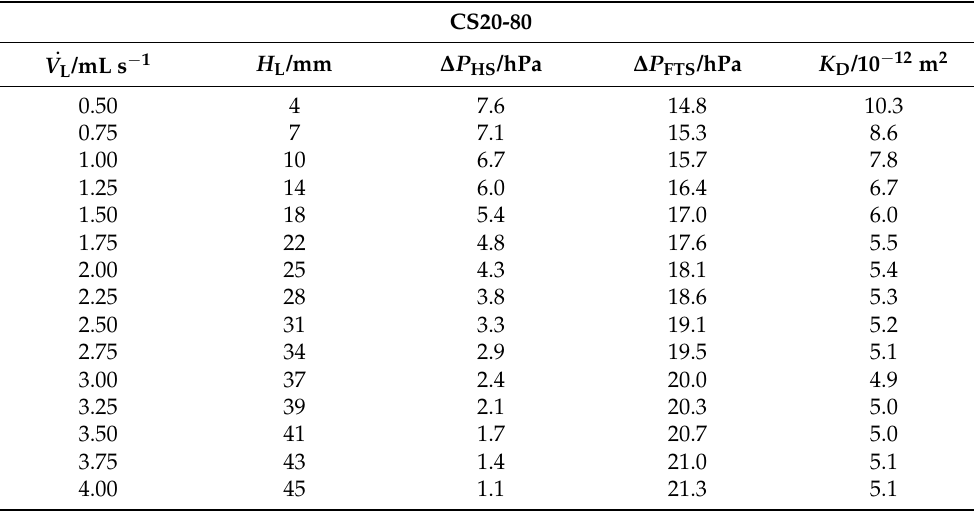
Table 5. Phase-separation experiment parameters and results for sample CS20-80 with ∆ P BP = 22.4 hPa,